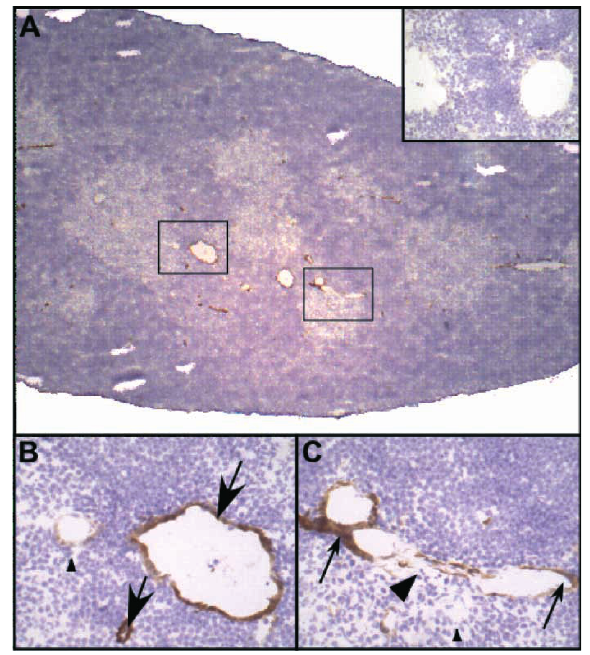
FIGURE 4 VAP-1 expression is restricted to a subset of venules found near the sites of progenitor homing. Panel A shows a low power image (40 £ original magnification) with an anti-VAP-1 antibody. Inset is an isotype-matched antibody control; rectangles show regions of interest enlarged in Panels B and C (400 £ original magnification). Parts of some venules near the cortico-medullary junction express high levels of VAP-1 (arrows), while others are very weakly stained or completely absent (arrowheads). M ¼ medulla, C ¼